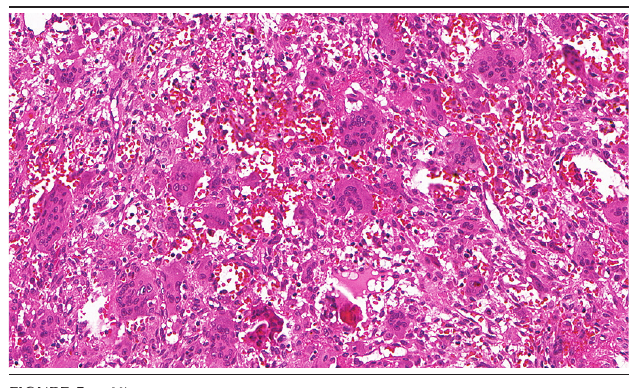
Photomicrography highlighting the proliferation of mononuclear mesenchymal cells associated with a population of multinucleated giant cells in a matrix of fibrous connective